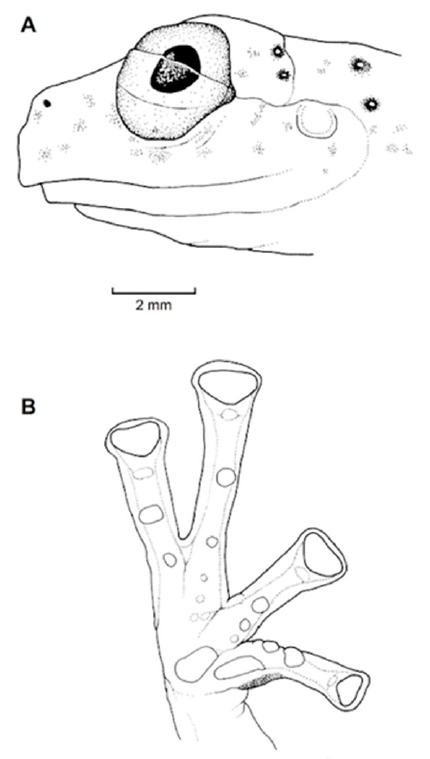
Figure 129. Nymphargus anomalus , adult male, KU 143299. ( A ) Head in lateral view. ( B ) Hand in ventral view. Illustrations by Juan M. Guayasamin.